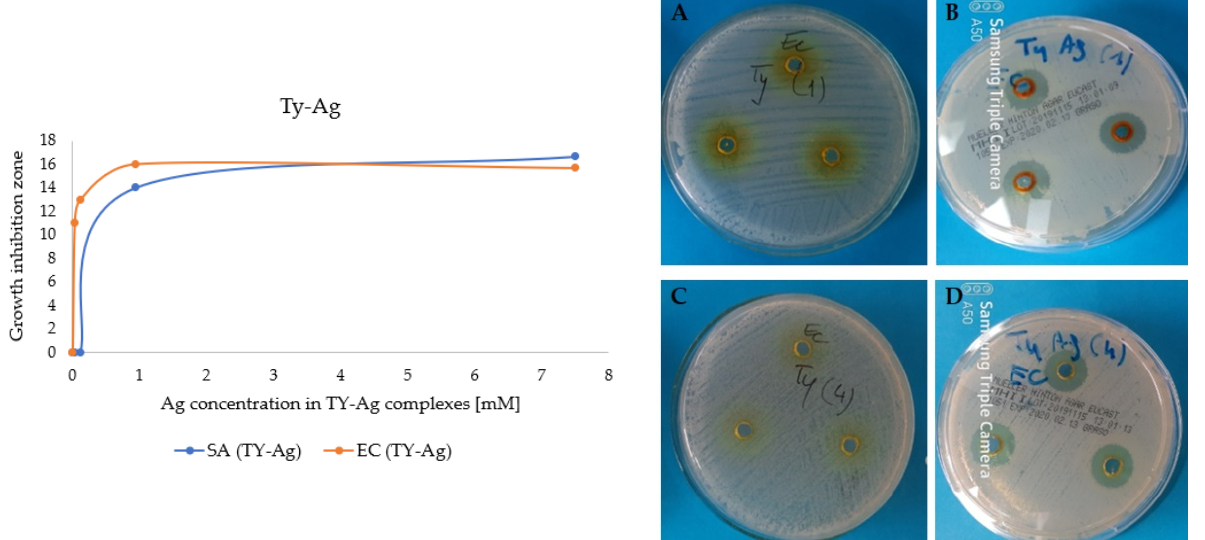
Figure 8. 5 mM of TY, or ( C ): 0.03 mM of TY ; ( B ): growth inhibition zones after adding 7.5 mM of Figure 8. Graph: Growth inhibition zones of E. coli and S. aureus after the addition of different Ag + complexed with 7.5 mM TY or ( D ): 0.03 mM Ag + complexed with 0.03 mM TY. concentrations of Ag + in the TY-Ag complex; ( A ): photos of plates: no growth inhibition zones after adding 7.5 mM of TY, or ( C ): 0.03 mM of TY; ( B ): growth inhibition zones after adding 7.5 mM of Ag + complexed with 7.5 mM TY or ( D ): 0.03 mM Ag + complexed with 0.03 mM